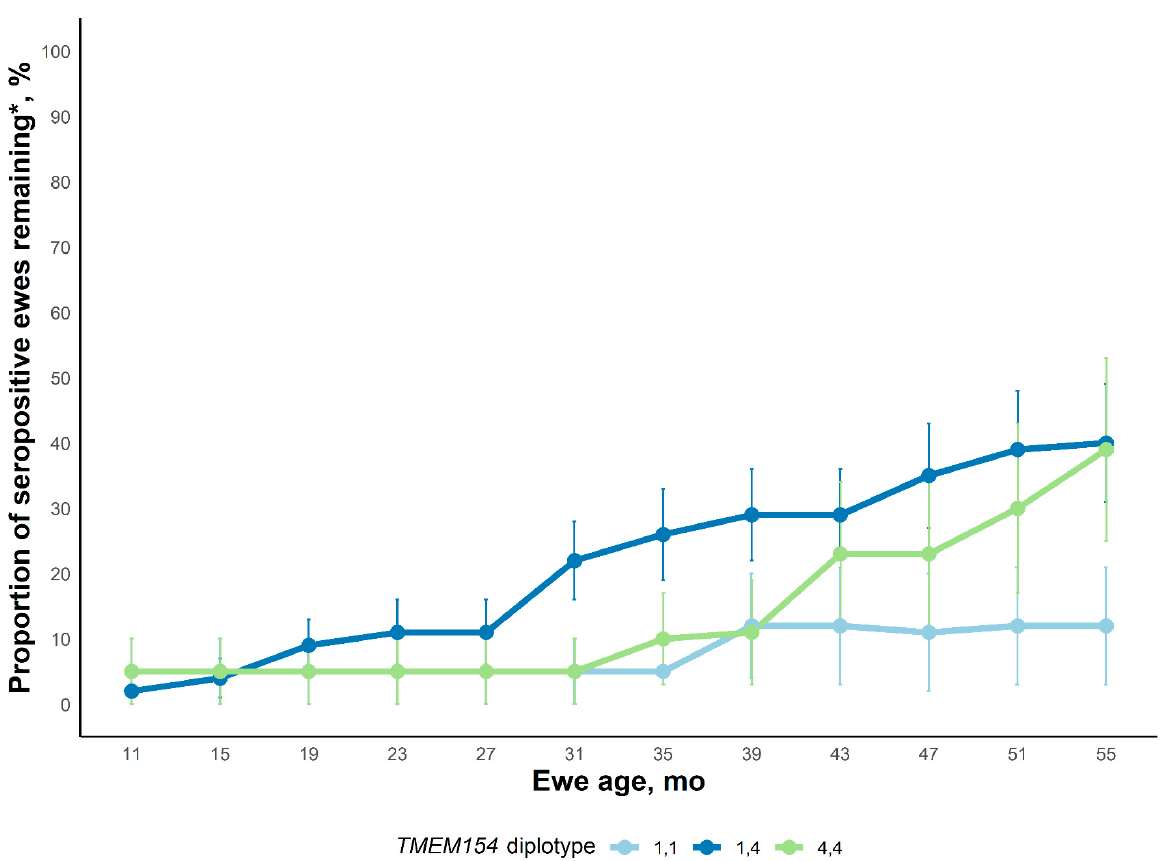
Figure 2. Proportion of ewes in Experimental flock 3 that were serologically positive by age of ewe. Ewes were sampled every 4 months throughout the experiment until three positive tests had been accumulated. Average least square means are presented at approximately each sampling age. The interaction of Age x Diplotype was not significant ( p = 0.90). The main effect of Diplotype was also not significant ( p = 0.53). The main effect of ewe age was significant ( p < 0.001). * Since ewes were culled from the flock for welfare reasons, the apparent seroprevalence can decrease on a percentage basis within a diplotype group between time points measured.